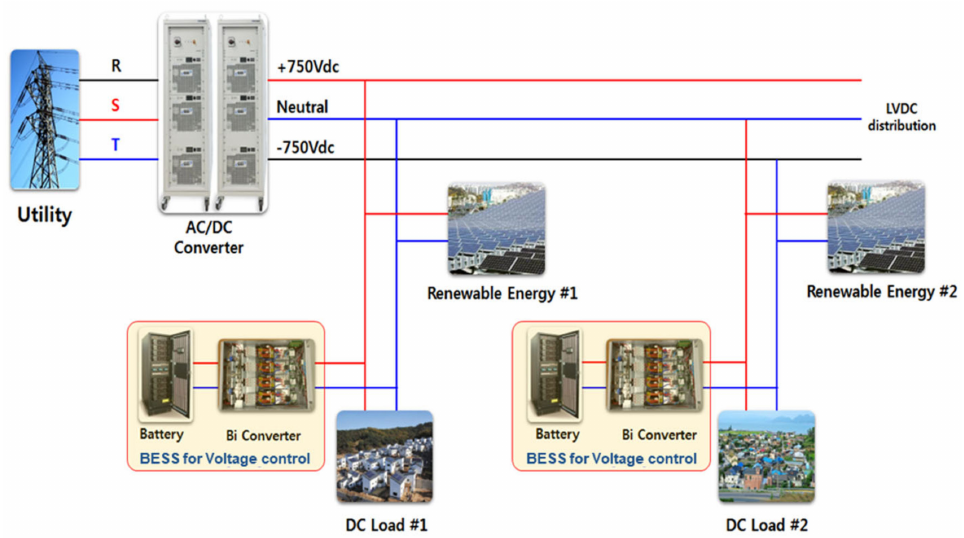
Figure 1. Overall structure of bipolar DC